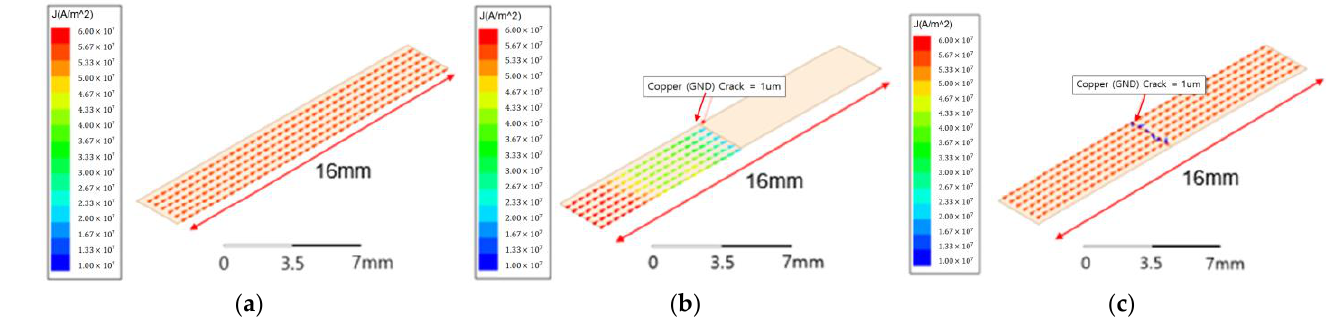
Figure 3. Side view of a structure including an outer ground copper with isotropic adhesive and signal layer.